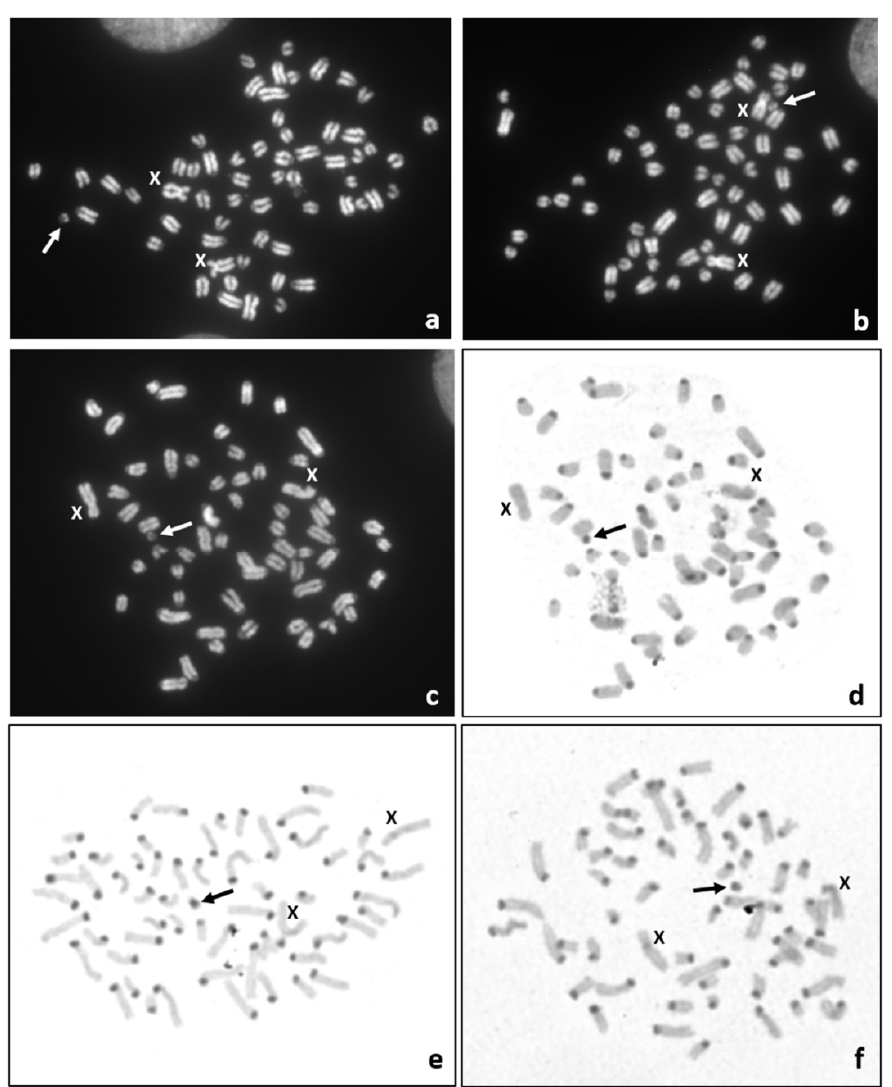
Figure 4. Representative metaphase spreads carrying a small marker chromosome (60,XX + mar): ( a – c )—DAPI staining; ( d – f )—C-banding. Note: sequential DAPI and C-banding of the same metaphase spread ( c , d ). The marker chromosome (arrow) and X chromosomes are indicated.